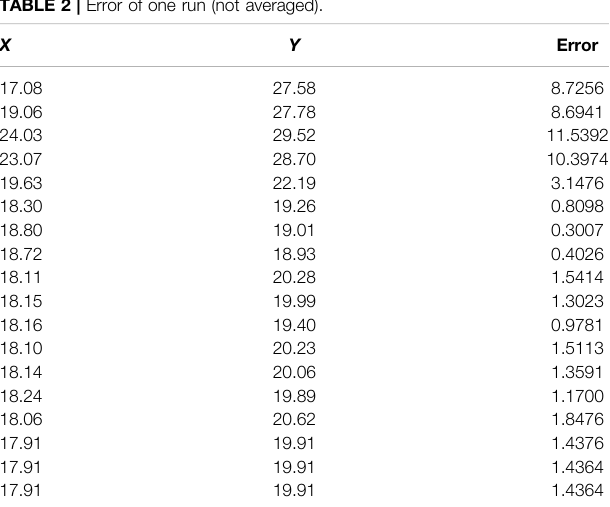
TABLE 2 | Error of one run (not